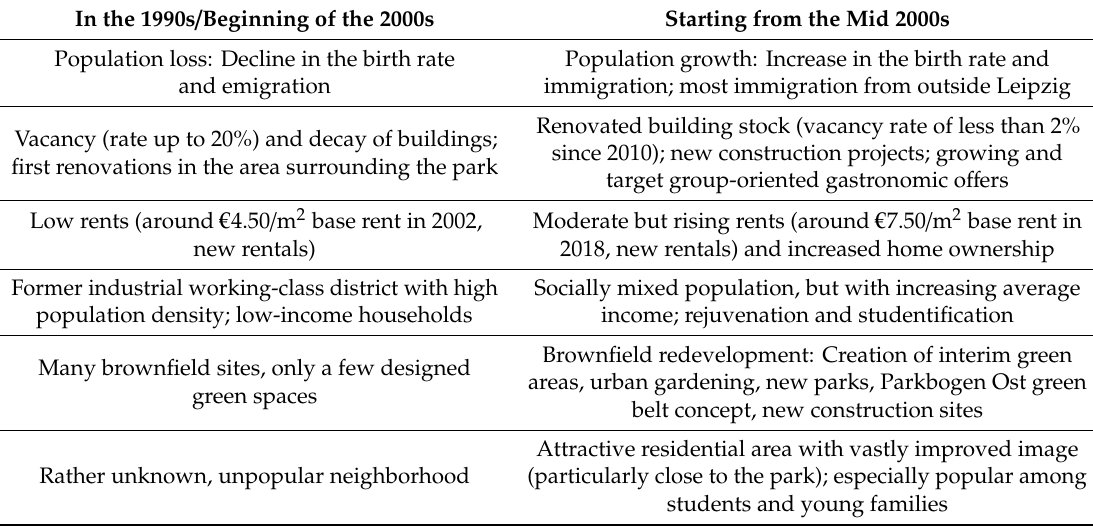
Table 3. Overview of the Lene-Voigt-Park (LVP) neighborhood development since 1990, based on the empirical